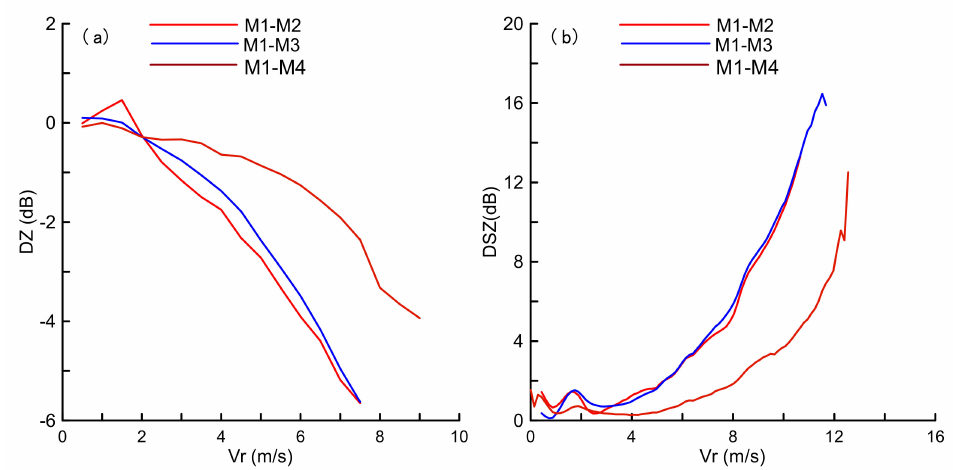
Figure 5. Ratios of ( a ) reflectivity and ( b ) Doppler spectral density measured by operational modes M2, M3, and M3 with M1 as a function of radial